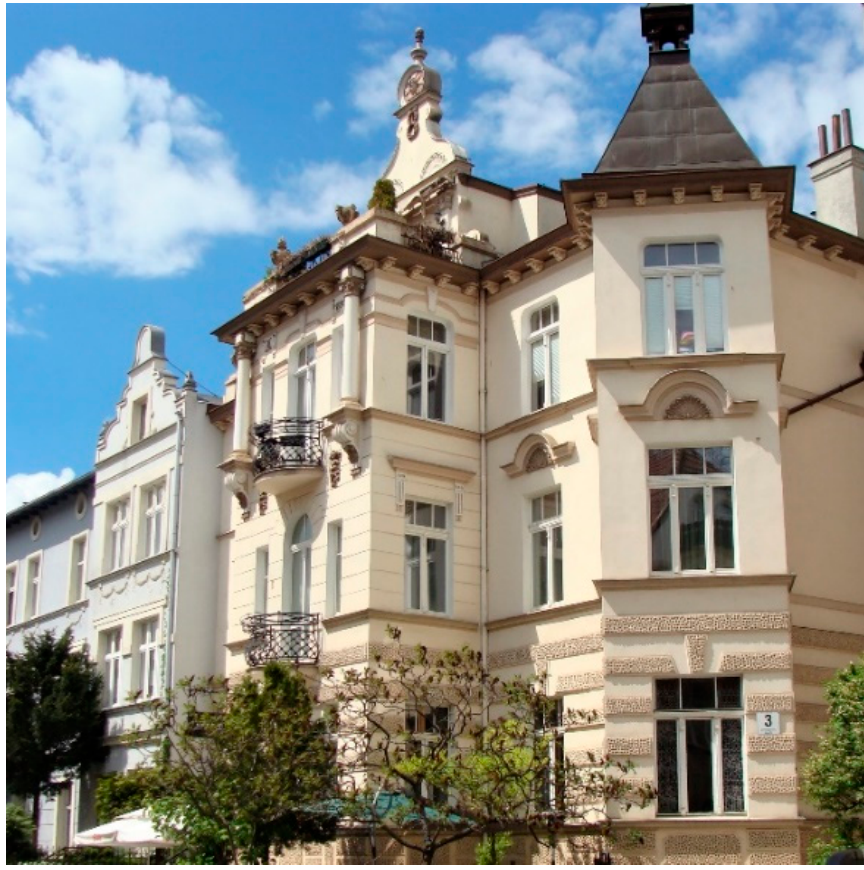
Figure 4. Tenement house, W ł adys ł awa Jagie łł y street in Sopot. Source: A. Taraszkiewicz.